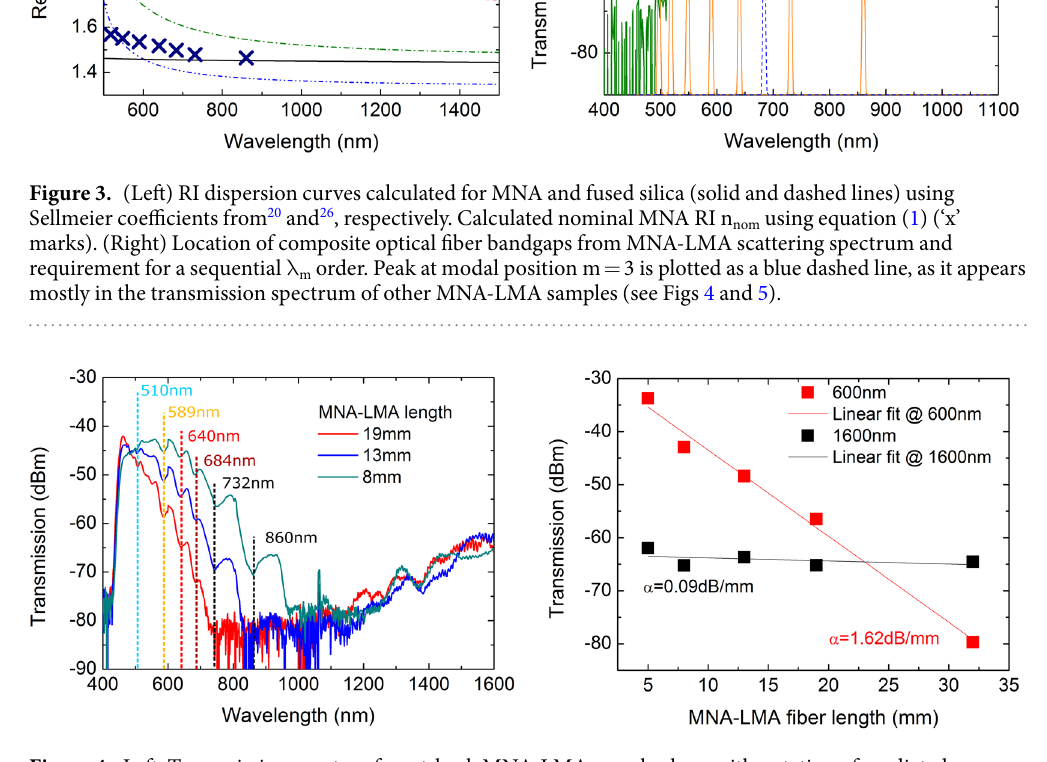
Figure 4. Left: Transmission spectra of a cut-back MNA-LMA sample along with notation of predicted bandgap location using ARROW model 22 . Right: Losses as a function of optical fiber length for a wavelength of 600 nm and 1600 nm.